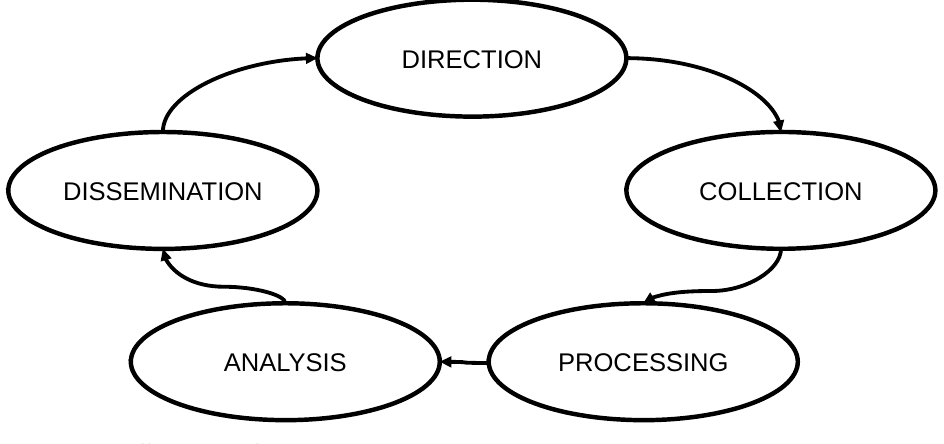
Figure 2. Intelligence